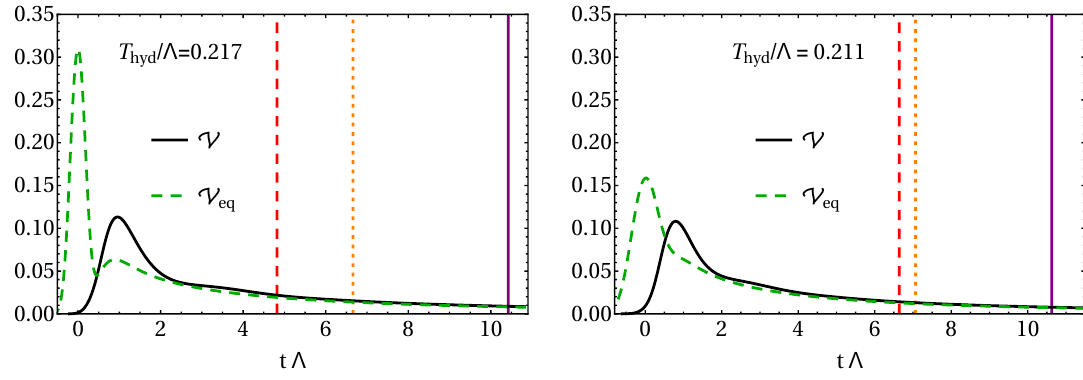
Figure 11 . Comparison between the time evolution of the true scalar condensate V at z = 0 and the equilibrium value V ( E ) that would correspond to the instantaneous energy density, in units eq of (cid:3) 3 , for collisions in the (cid:30) = 20 model of shocks with the same transverse energy (cid:22)= (cid:3) = 0 : 62 M but di(cid:11)erent widths (cid:22)! = 0 : 12 (left) and (cid:22)! = 0 : 30 (right). The vertical lines indicate the hydro- dynamization time (red dashed), the EoSization time (purple solid) and the condensate relaxation time (orange dotted). These times, in units of 1 = (cid:3), take the following values in each panel. Left: t hyd = 4 : 82 < t cond = 6 : 66 < t EoS = 10 : 42. Right: t hyd = 6 : 64 < t V = 7 : 07 < t EoS = 10 :